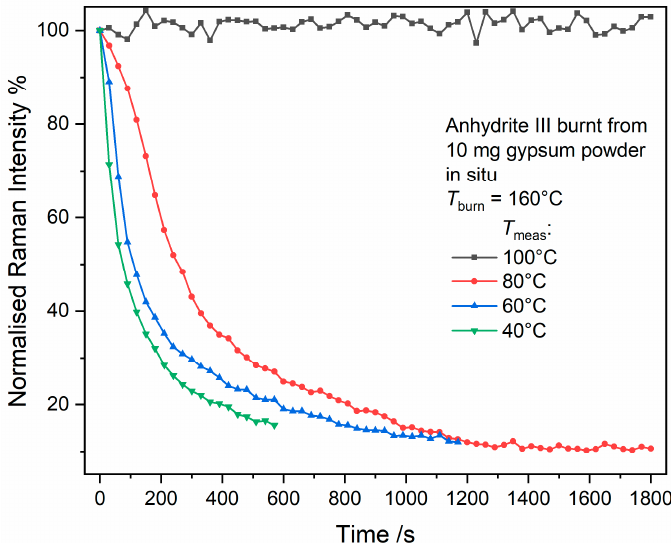
Figure 15. Trend of normalised Raman intensities of anhydrite III ν 1 band during exposure to ambient air at different temperatures. Anhydrite III was synthesised by burning 10 mg gypsum powder at 160 °C for 5 min.